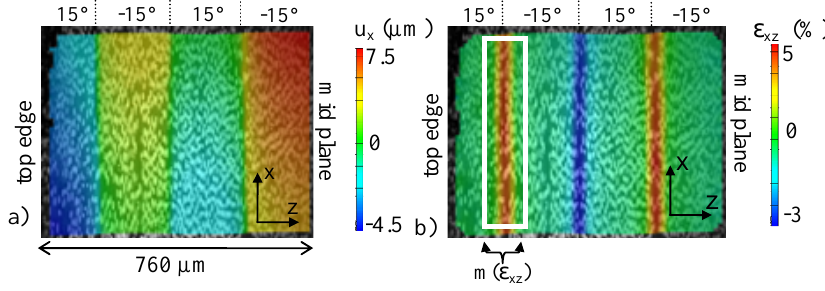
Fig. 5. u x displacement (a) and e xz shear strain (b) measured on pure-UD-HS [(15/-15) 2 ] s laminate edge at < e xx > = 0.4%, DIC parameters (L,D) set to (30,20) pixels, 1 pixel = 0.55